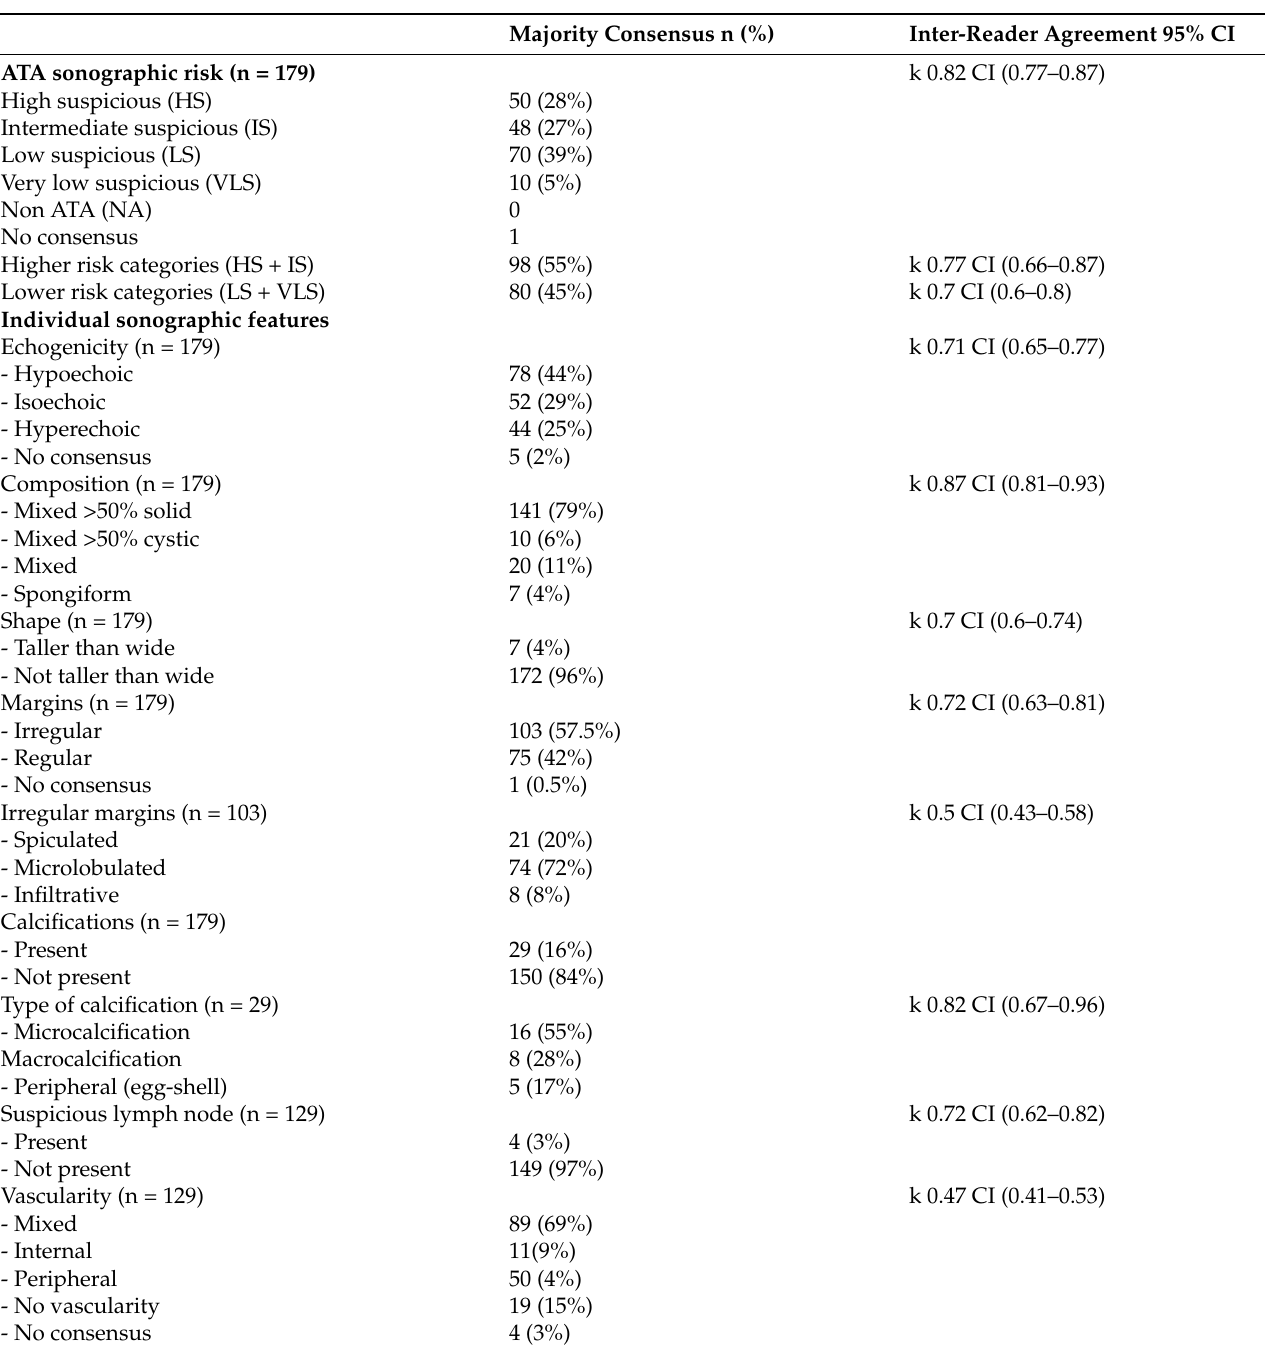
Table 2. Frequency of ATA sonographic risk, individual sonographic features and Inter-reader agreement calculated with Fleiss Kappa for 95% confidence